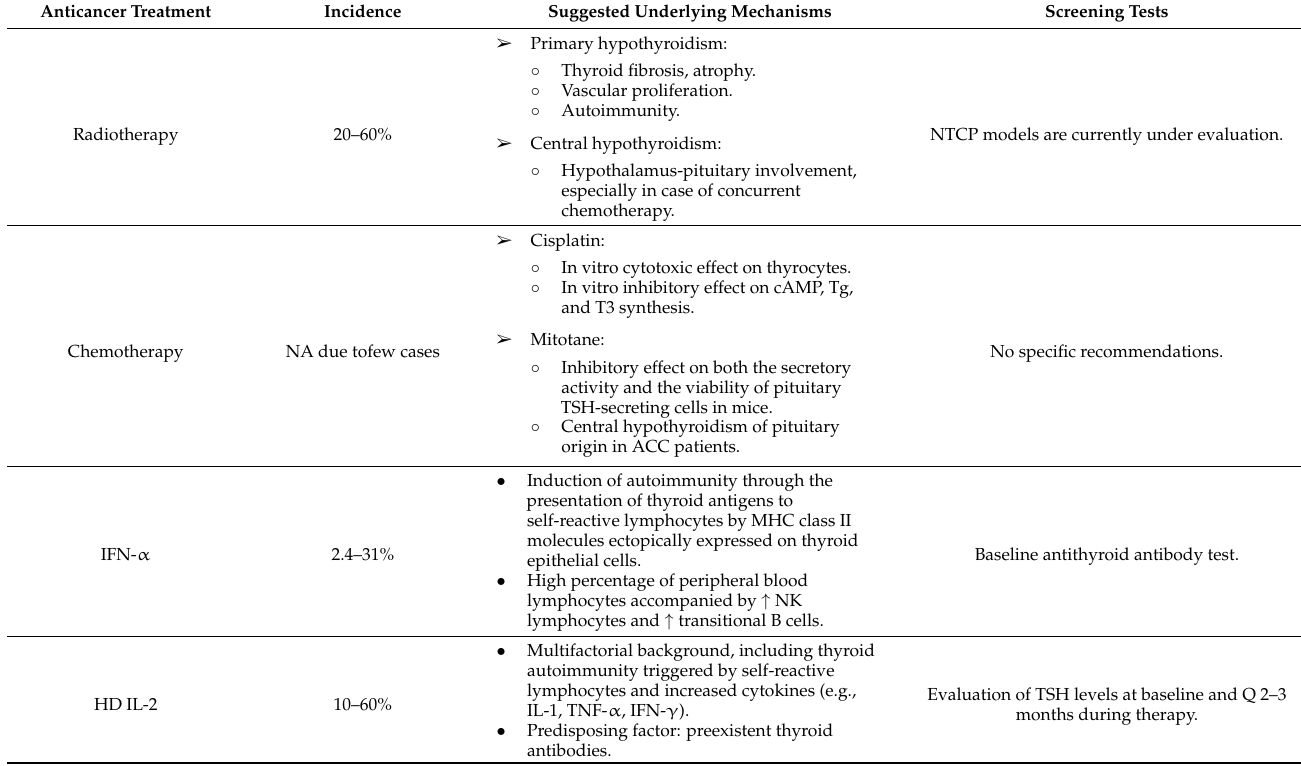
Table 1. Anticancer treatment-related causes of